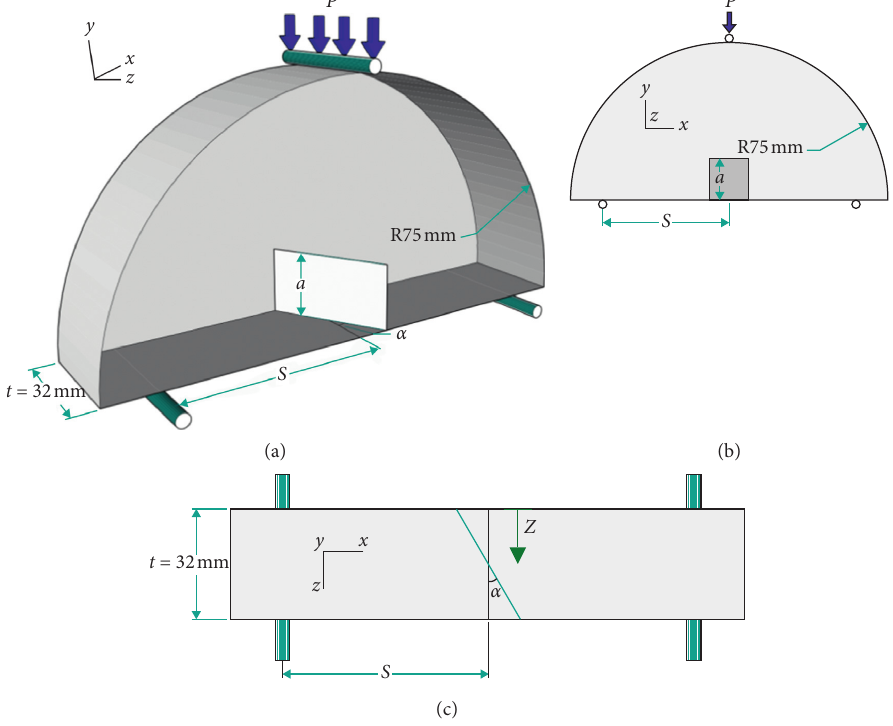
Figure 1: Geometry and loading configuration of SCB specimen. (a) Three-dimensional view; (b) front view; (c) top